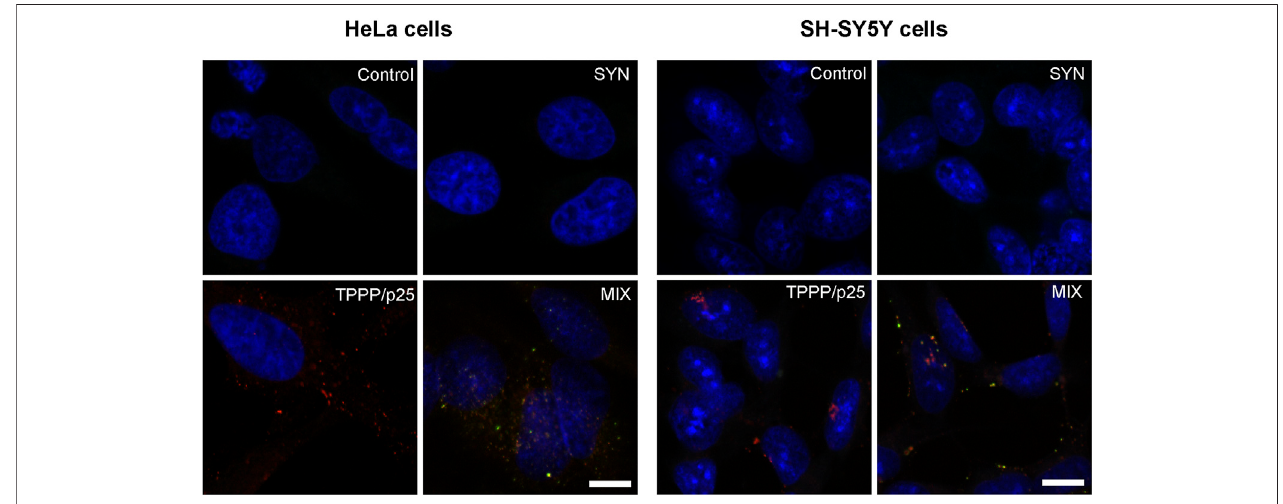
FIGURE 8 | Visualization of the assembly of SYN (green) and TPPP/p25 (red) by fl uorescence confocal microscopy in HeLa and SH-SY5Y cells. TPPP/p25 and/or SYN were added to the medium for their transmission into the cells. Representative images were evaluated by speci fi c TPPP/p25 and SYN antibodies. Nuclei were counterstained with DAPI (blue). Scale bars: 10 μ m.